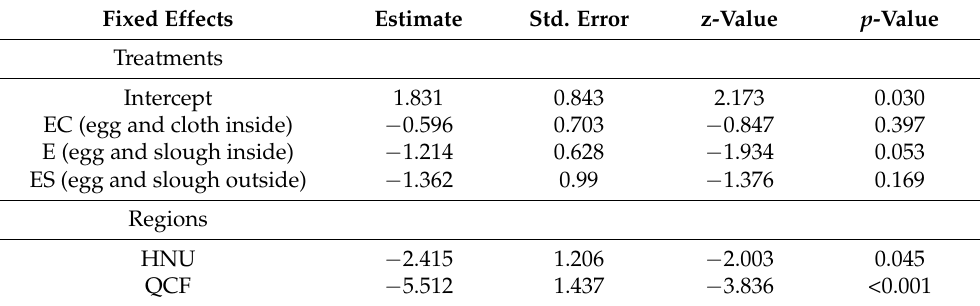
Figure 5. Egg survival curves of different treatments in three regions ( p refers to the significance of survival curves in different treatments). Table 1. Comparison of nest predation among different treatment groups and regions by GLMM (the treatment reference level was the control group C; the region reference level was